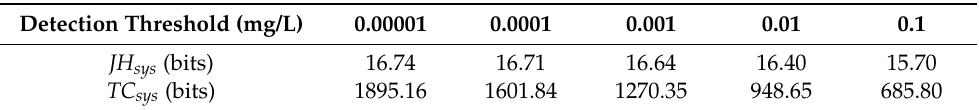
Table 3. JH and TC of the system for different